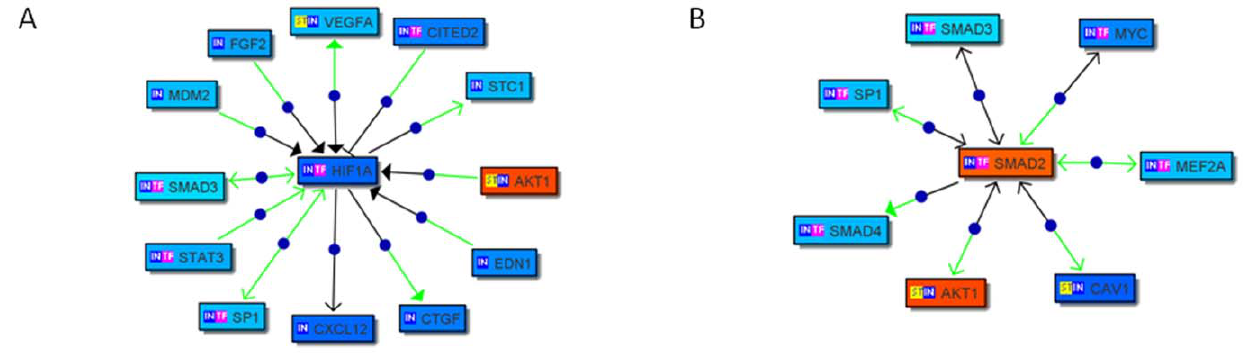
Figure 2. Bibliosphere analysis of transcripts where two genes are co-cited and restricted to sentences with gene + function word + gene. sentences with expert curated information. Each rectangle depicts a single gene. Red indicates the gene is unregulated, blue downregulated. Arrows between two genes shows regulatory mechanisms: green indicates a transcription factor binding site match in the target promoter; open arrowhead indicates regulation; filled arrowhead indicates activation; blocked arrowhead indicates inhibition; blue dot on the edge indicates that the connection has been annotated by experts; A: Associations present between HIF1A and other genes at the expert level; B: Associations present between SMAD2 and other genes at the expert level. IN: gene is an input gene; TF: gene’s product is a transcription factor; ST: gene product is part of signal transduction pathway.